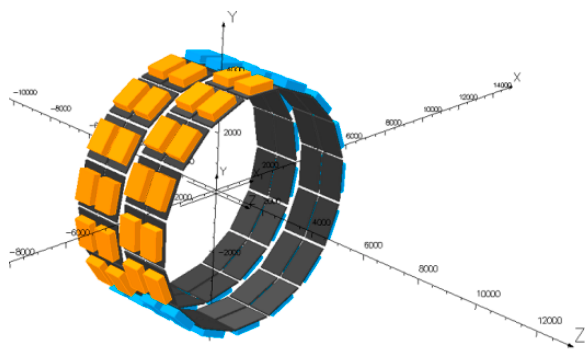
Figure 16. Allocation of EMAT inspection sensors for circumferential defects (unit: mm).